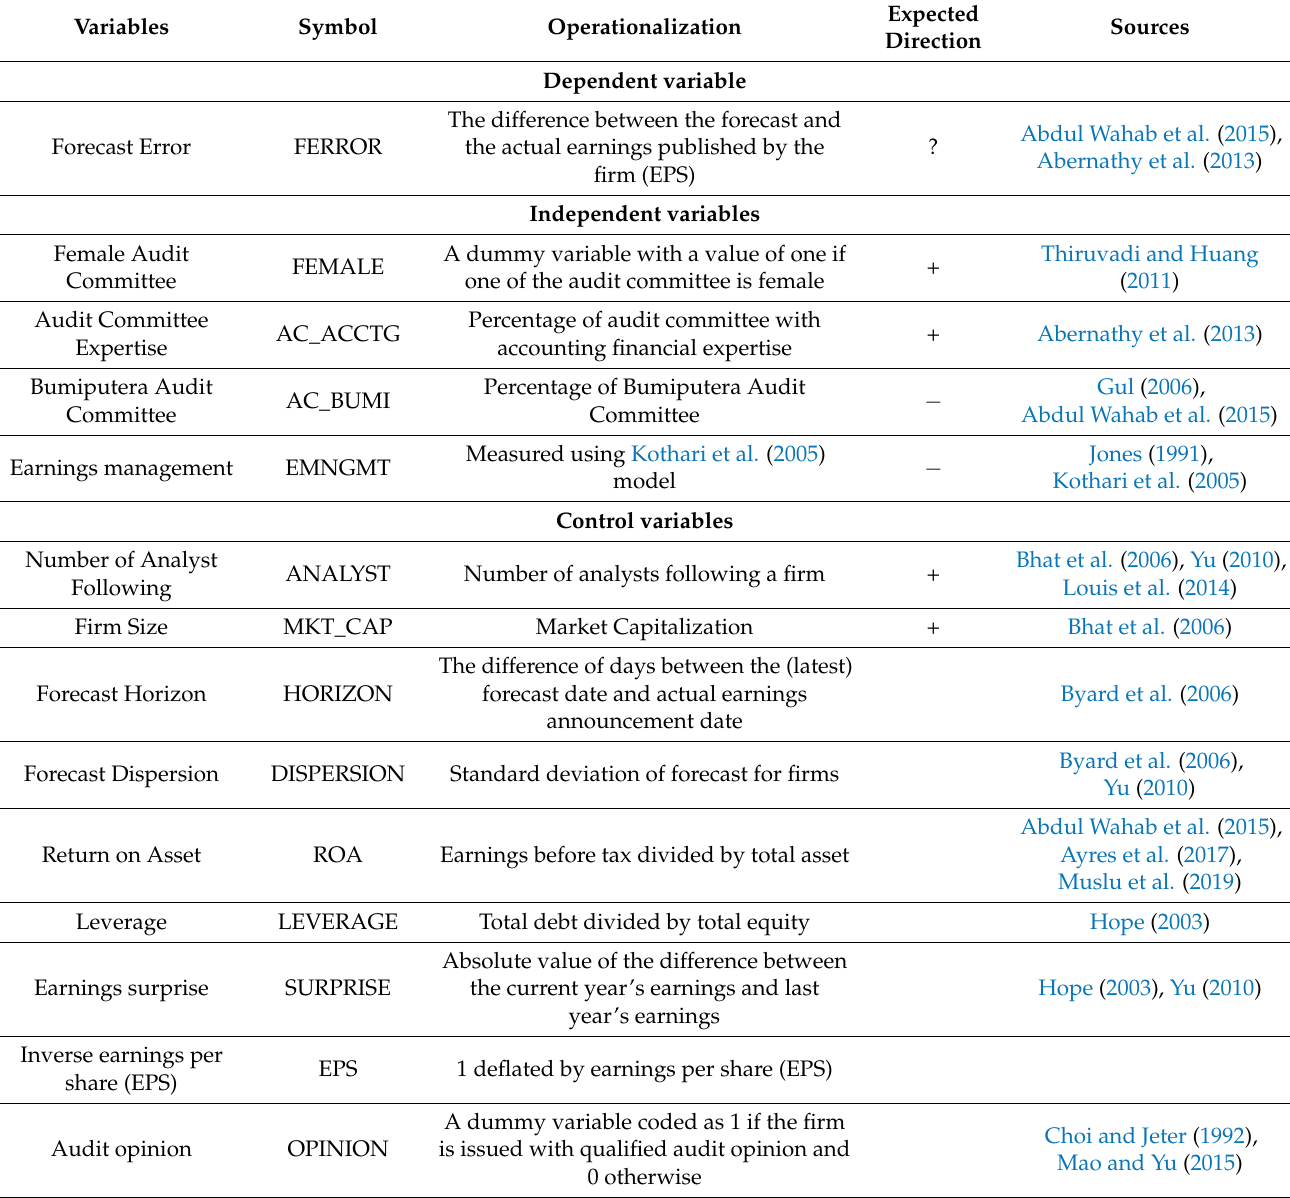
Table 2. Operational Definition of Variables: List of variables used in the study and their